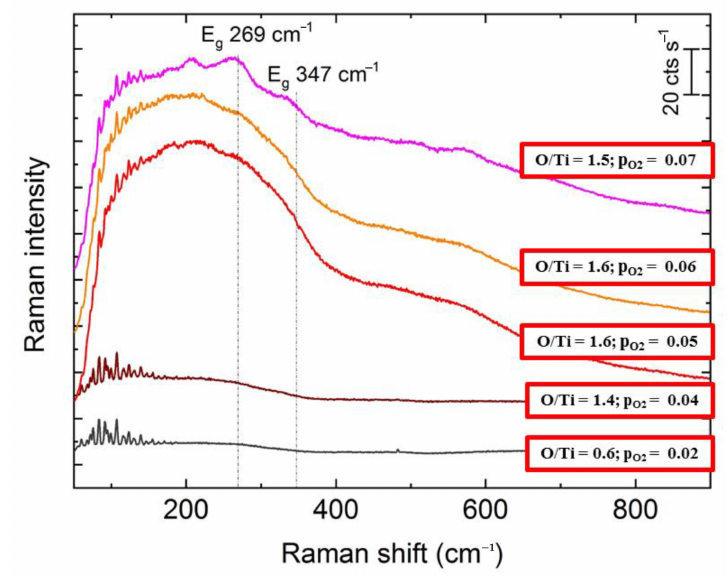
Figure 7. Raman spectra of samples in G1. Ti 2 O 3 lines from Ref. [20] are indicated in the graph. The spectra were offset vertically for better visibility.